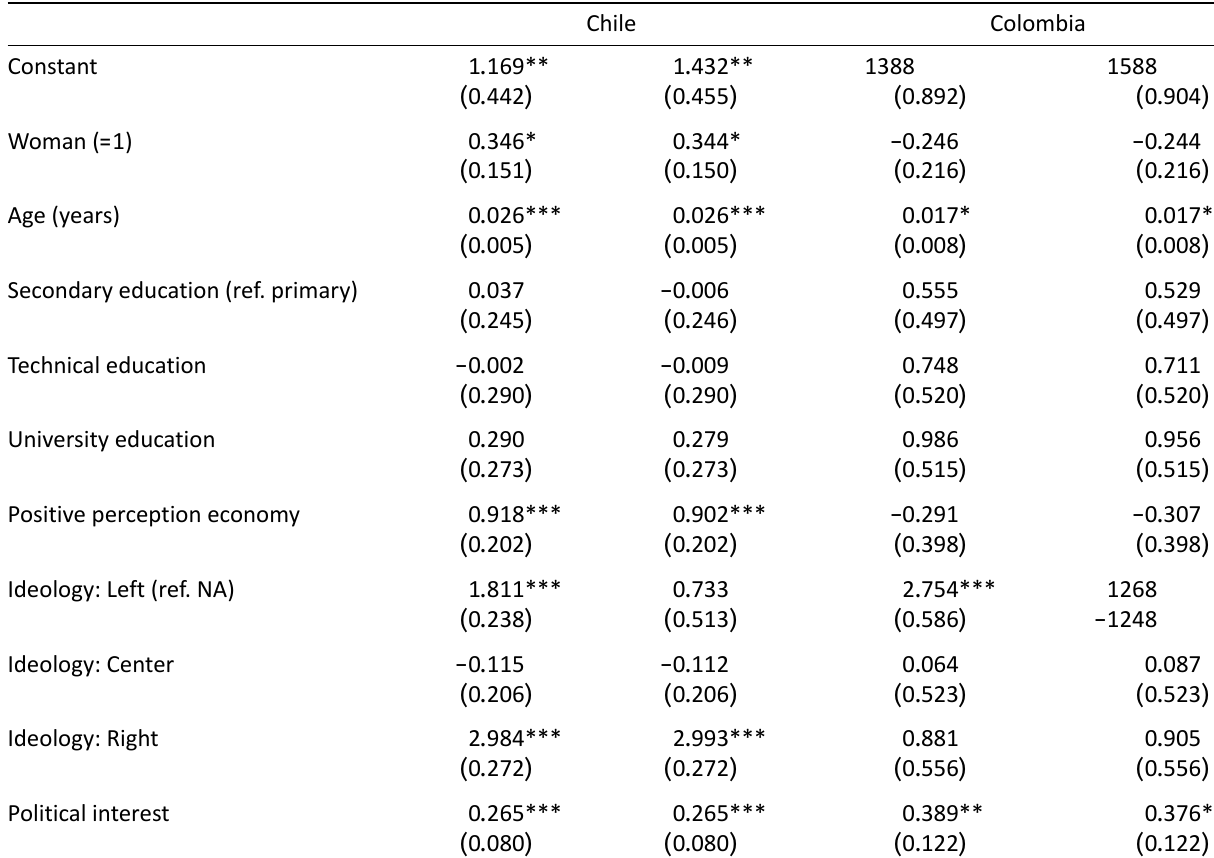
Table 3. Determinants of affective